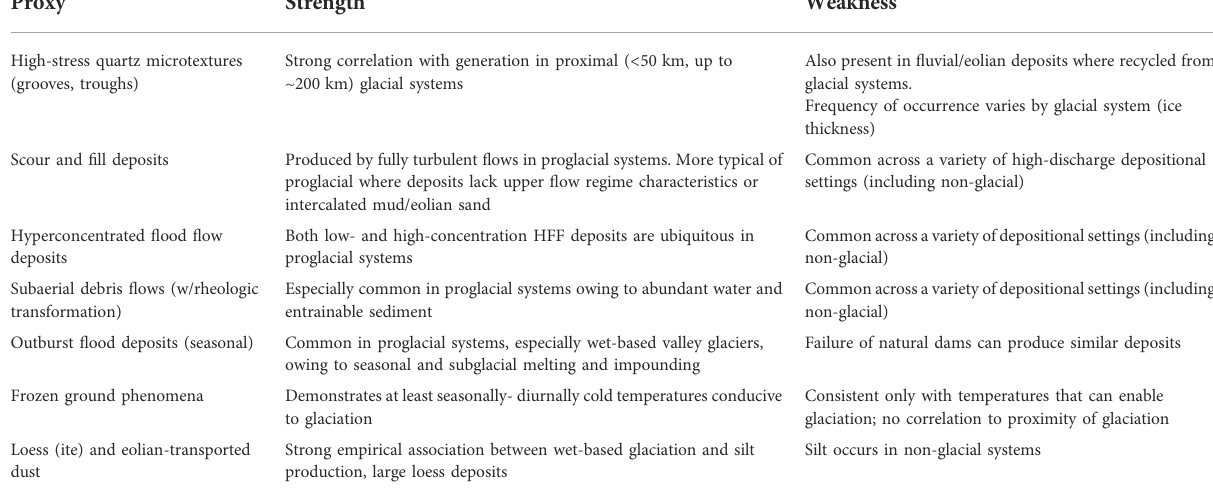
TABLE 4 Summary assessment of proxies discussed in this